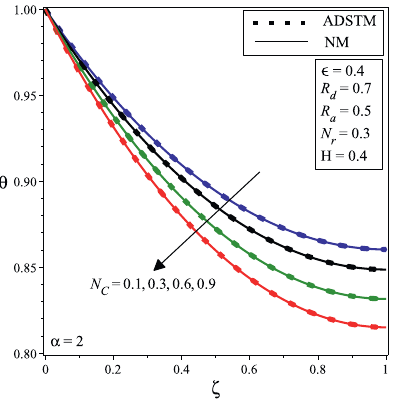
Fig. 4: Effect of convection–conduction parameter, N c and compar- ison between the ADSTM with the numerical solution for classical order α = 2.0.